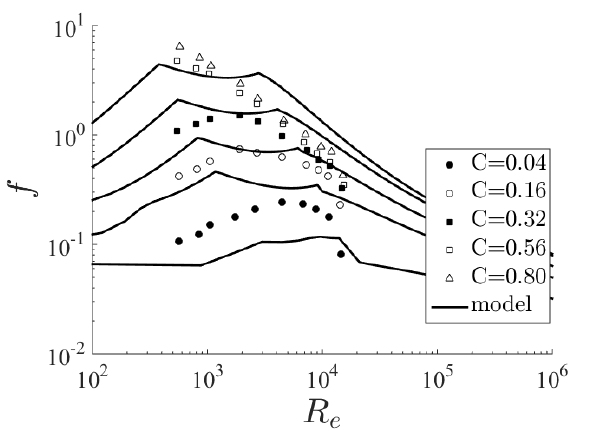
Figure 9. Friction factor as a function of Reynolds number compared with the experiments of [23] (gravels). The diameter and height are equal to the mean diameter D = k = 0.03 m for randomly spatialized obstacles with fixed concentration.